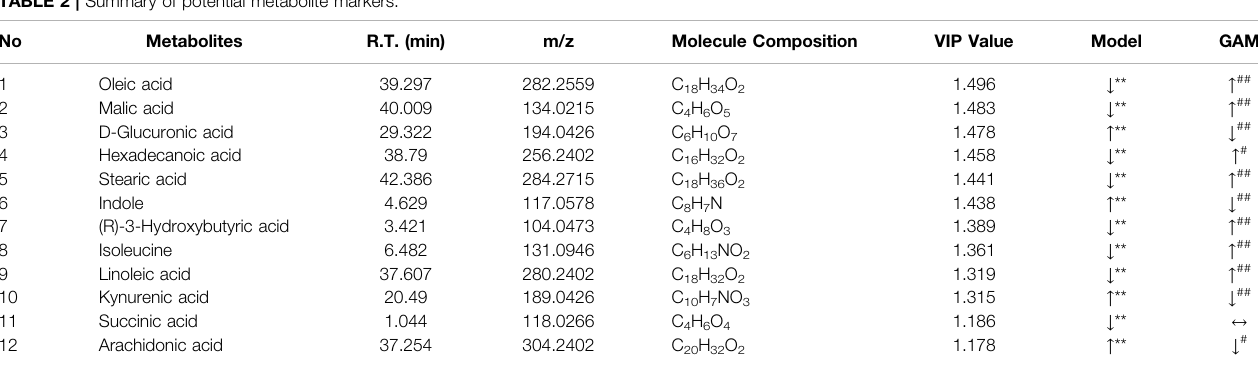
TABLE 2 | Summary of potential metabolite